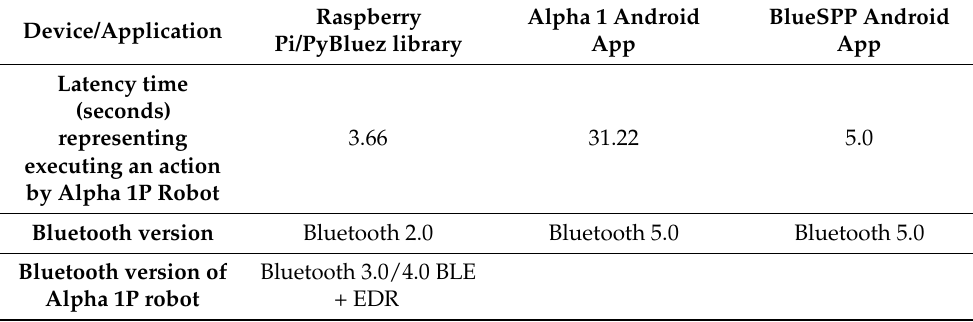
Table 8. Latency results for execution time of Alpha 1P robot’s